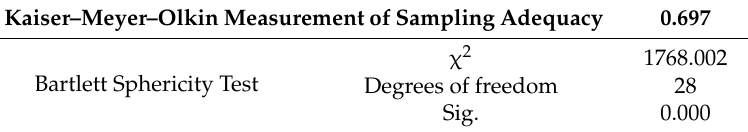
Table 4. Kaiser–Meyer–Olkin (KMO) and Bartlett test.